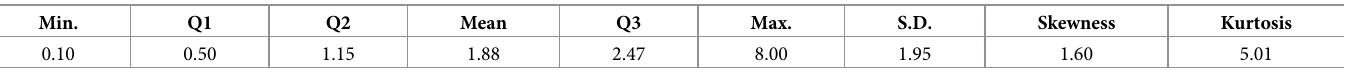
Table 11. Descriptive statistics of Vinyl chloride data ( μ g/L). Min.